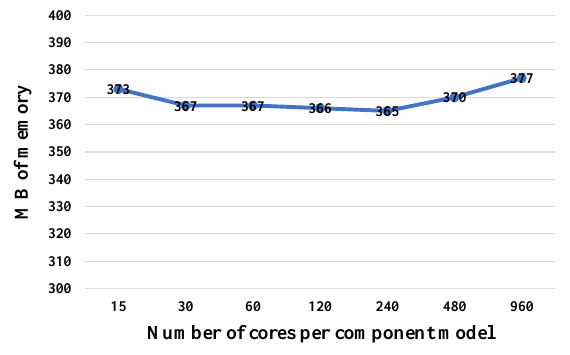
Figure 10. Memory use of C-Coupler2 for the trial coupled model considered in Sect. 5.2.